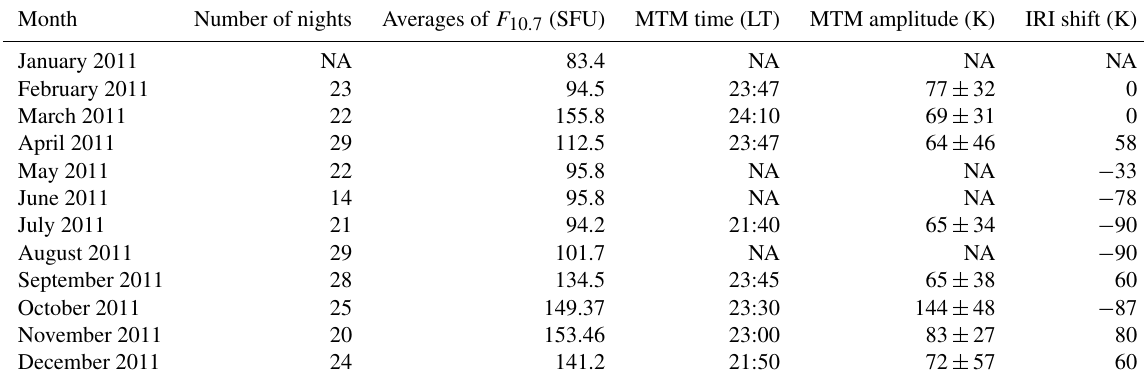
Table 1. Summary of observations made with the FPIs. NA means not available. Month Number of nights Averages of F 10 . 7 (SFU) MTM time (LT) MTM amplitude (K) IRI shift (K) NA 83.4 NA NA NA 23